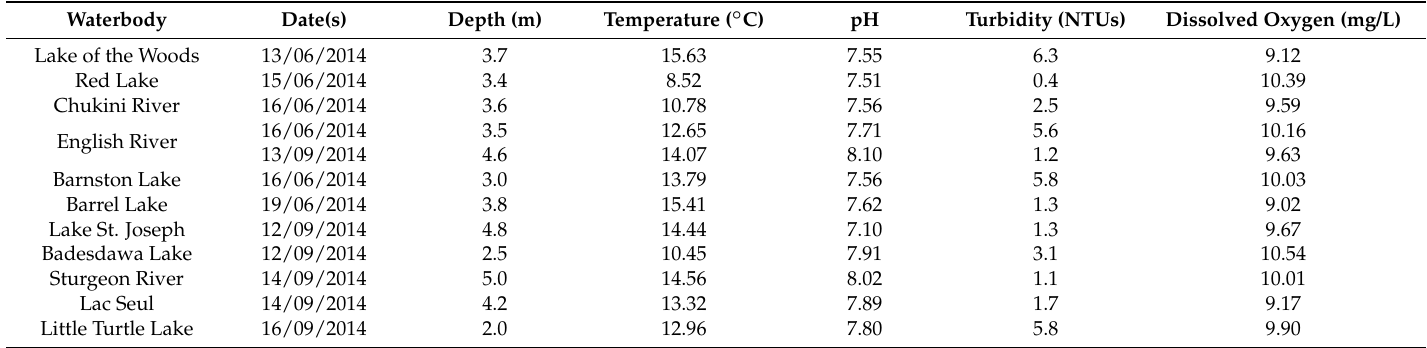
Table 5. Mean measured habitat parameters, including depth, temperature, pH, turbidity, and dissolved oxygen from selected River Darter collection